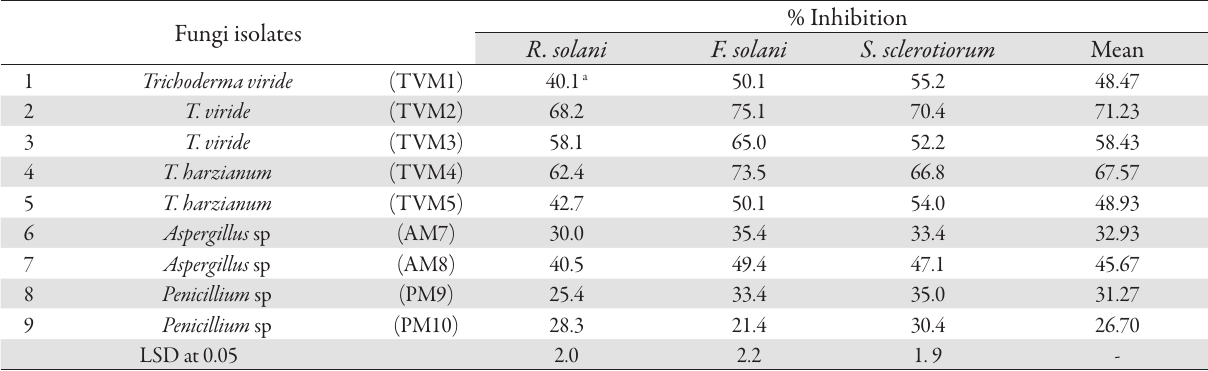
Tab. 4. In vitro antagonistic action between the fungal isolates and the tested fungi Fungi